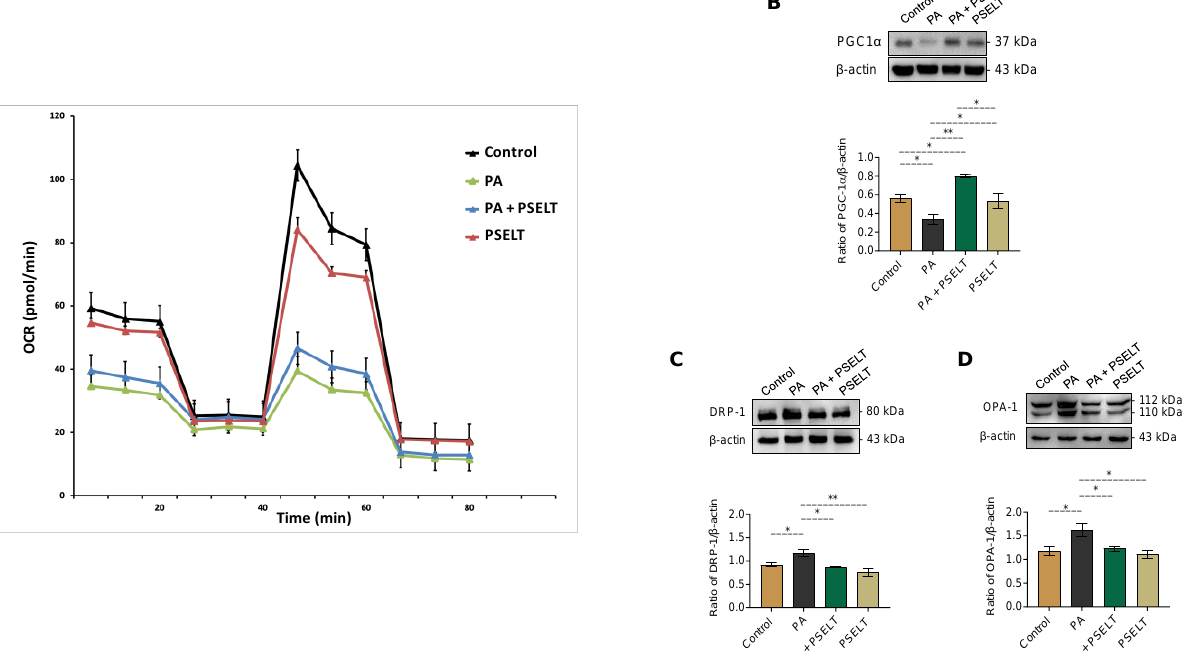
Figure 5. Effects of PSELT on mitochondrial respiration, biogenesis, and dynamics in H9c2 cells exposed to PA. ( A ) Evaluation of the mitochondrial respiratory capacity in H9c2 cardiomyocytes by Seahorse XF Analyzer after 24 h treatment with PA or PSELT alone or in combination and quantification of the oxygen consumption rates (OCR). Western blot analysis of ( B ) PGC-1α, ( C ) DRP-1, and ( D ) OPA-1 in H9c2 cardiomyocytes treated with vehicle (Control), PA 100 µmol/L, PA + PSELT 5 nmol/L or PSELT for 24 h. Histograms represent the ratio of the densitometric analysis of protein:loading control. Data are expressed as the mean ± SEM ( n = 3 independent experiments). Significant differences were detected by one-way ANOVA and Newman-Keuls multiple comparison test. p < 0.05 (*); p < 0.01 (**).